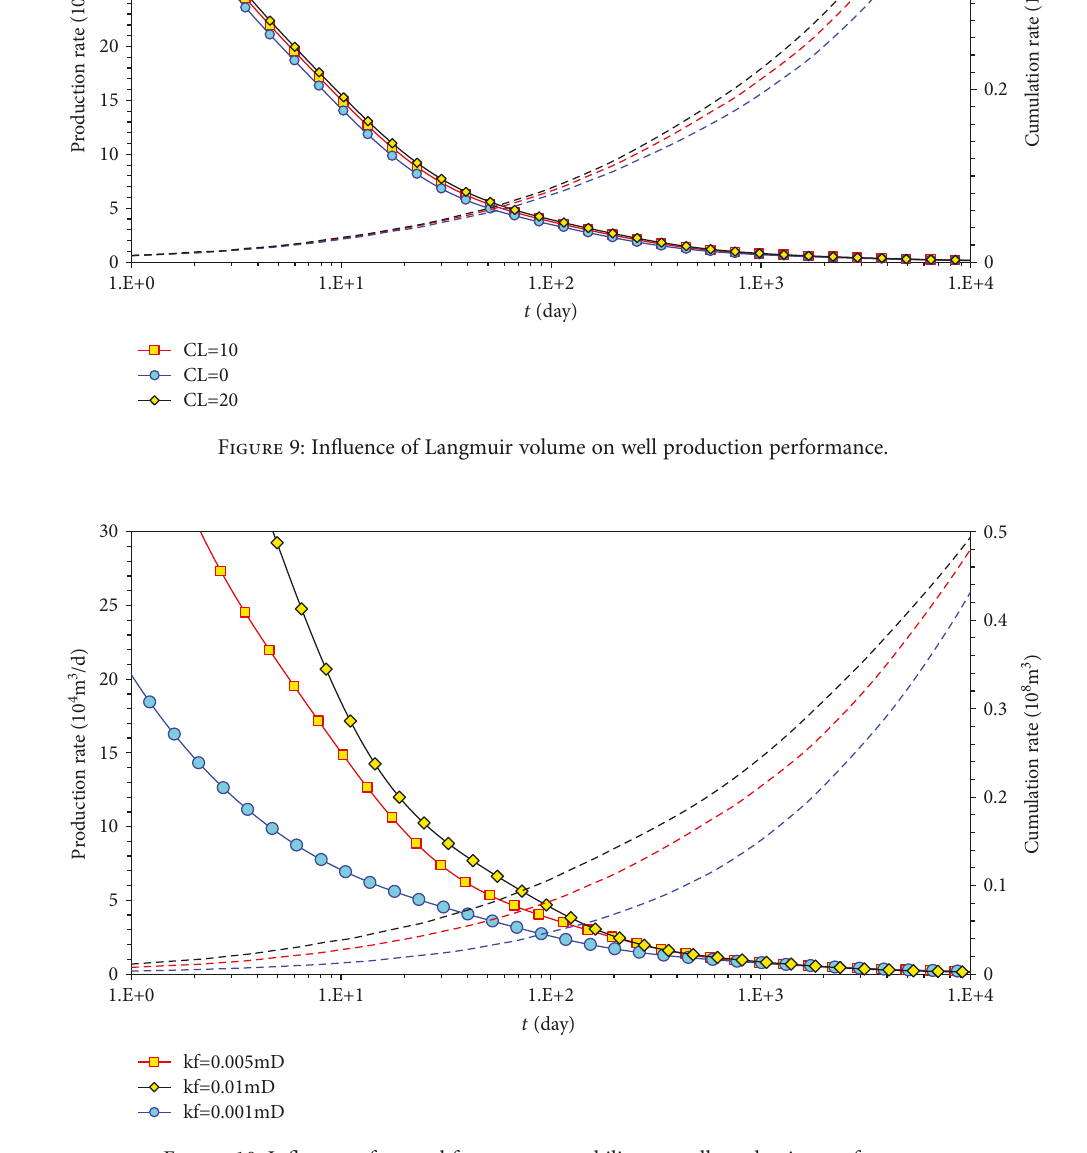
Figure 10: In fl uence of natural fracture permeability on well production